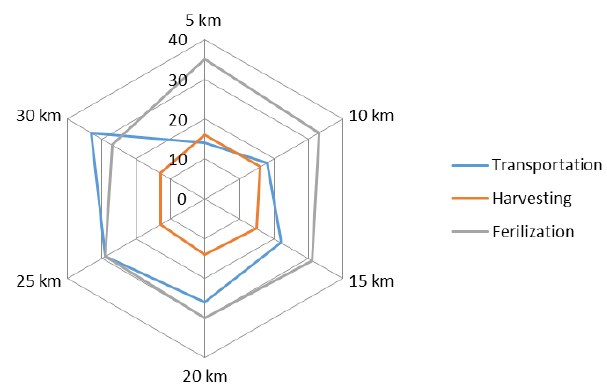
Figure 10. The contribution of the transportation, harvesting, and fertilization operations in the total